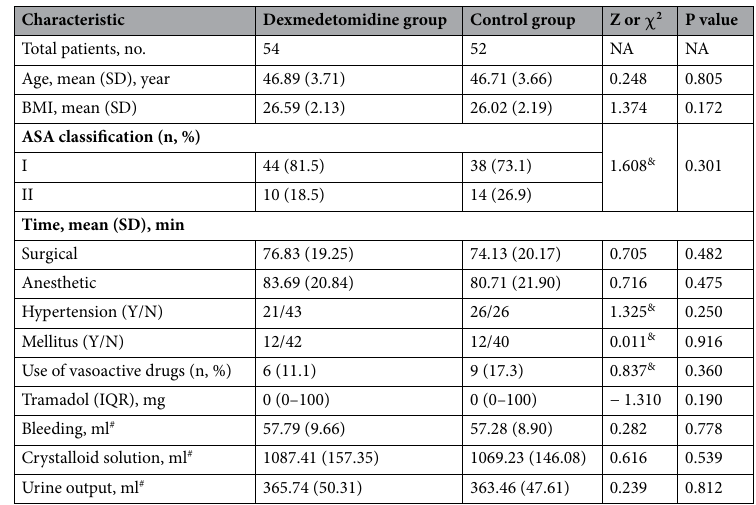
Table 1. Patient characteristics and baseline data. NA not applicable, ASA American society of anesthesiologists, BMI body mass index, SD standard deviation, n number, Y yes, N no. # Values were rounded to the nearest 10 mL. & χ 2 value.